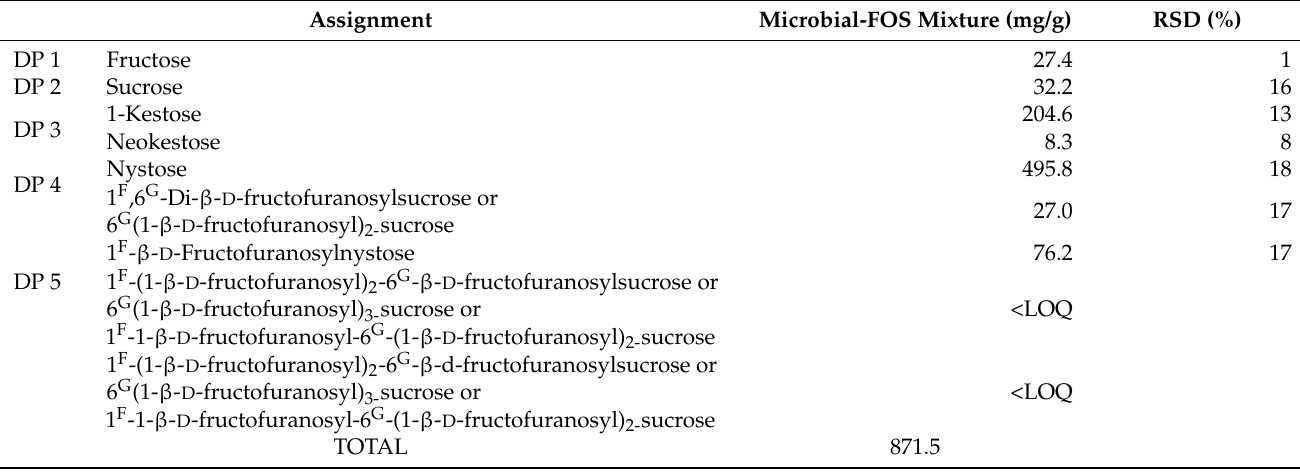
FOS—fructo-oligosaccharides; RSD (%)—relative standard deviation; DP—degree of polymerization; LOQ—limit of quantification (0.018 mg for stachyose